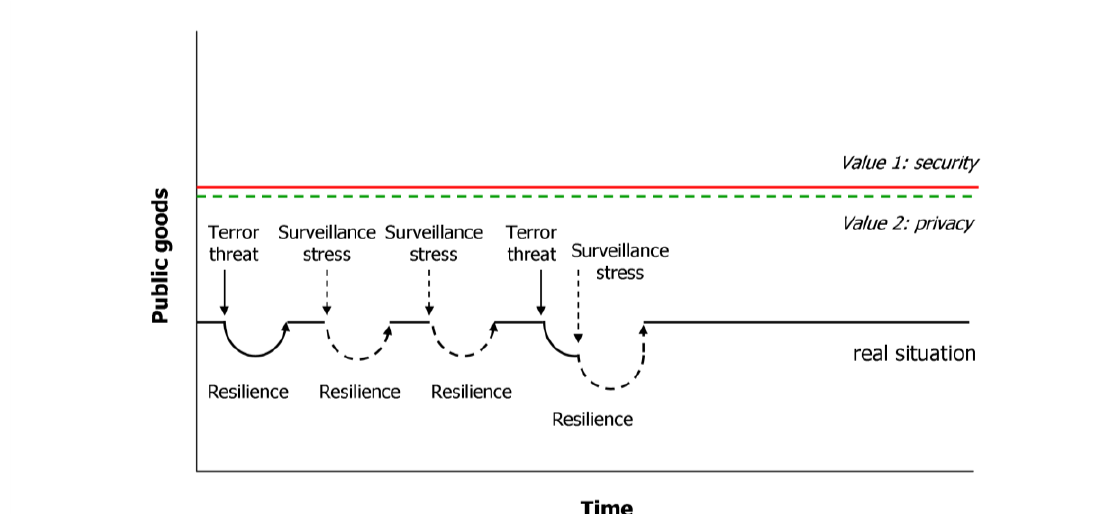
Figure 11. Terror threats and surveillance stresses in a separate public goods model (ideal situation).